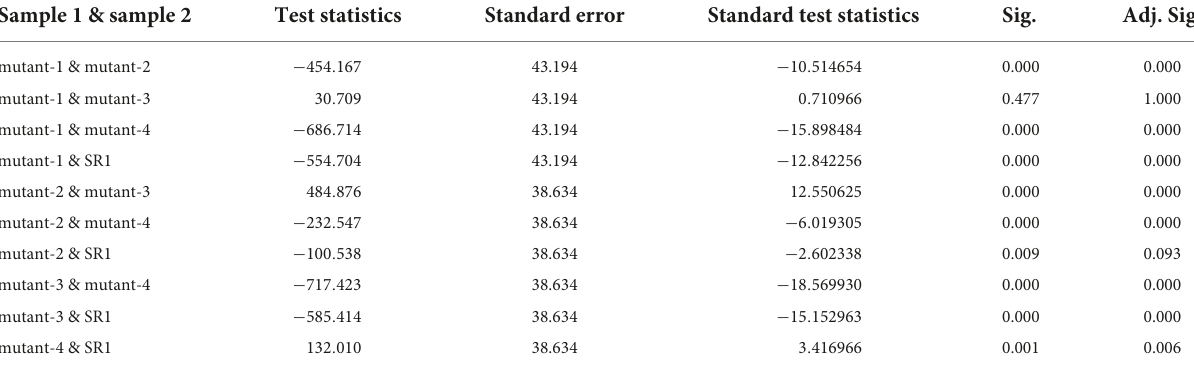
TABLE 2 The independent samples Kruskal–Wallis test of green fluorescence brightness.